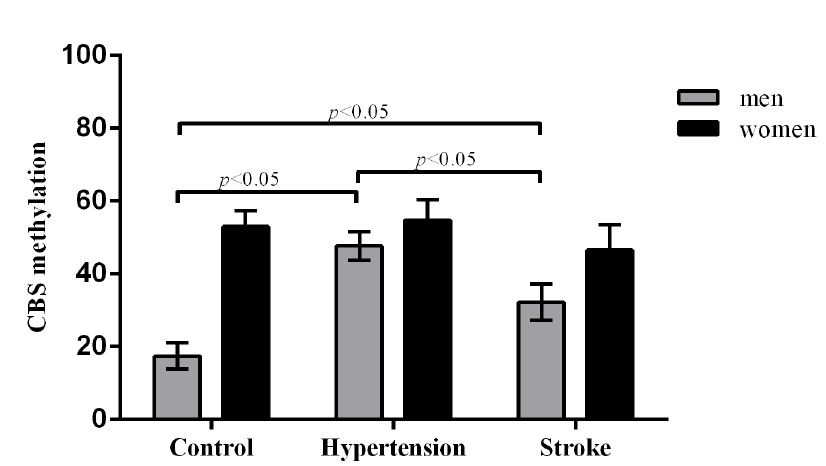
Figure 2 - Comparison of CBS methylation levels between healthy controls and hypertensive and stroke